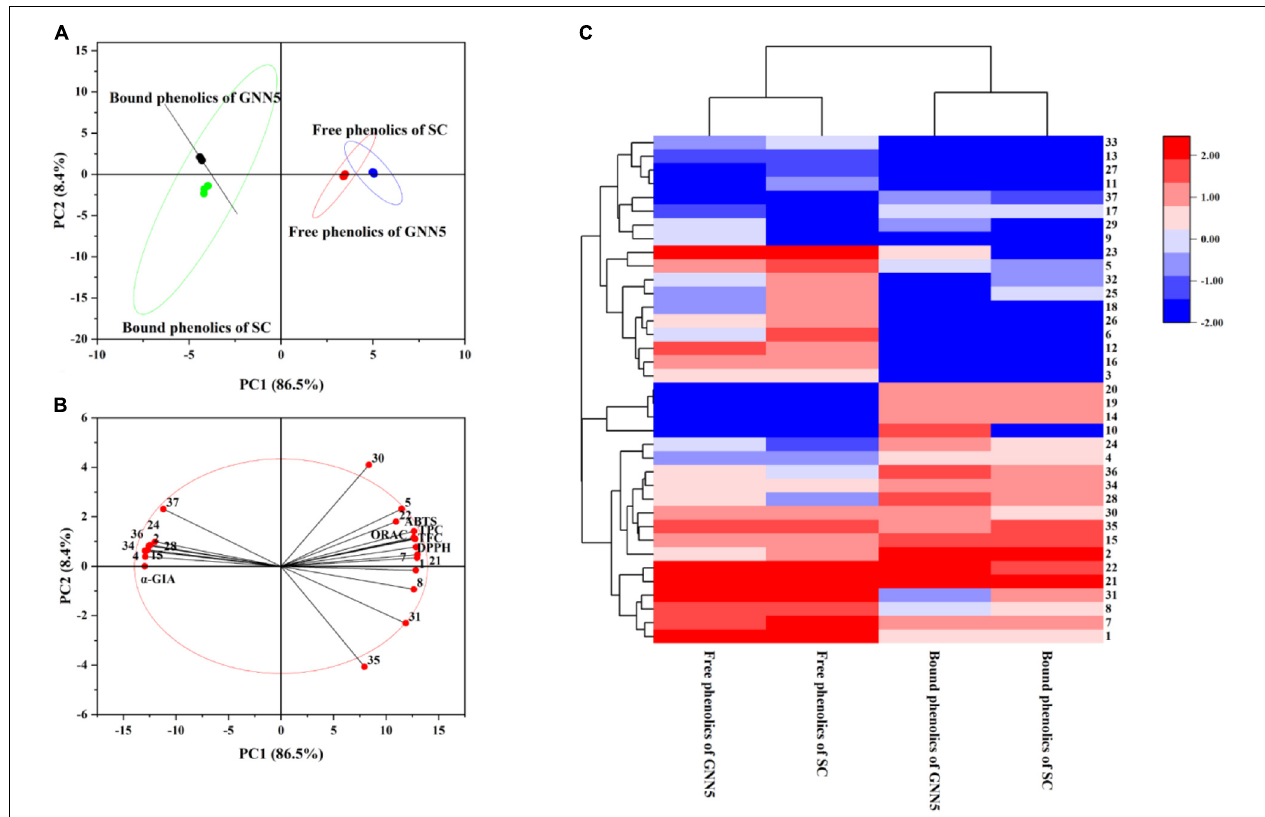
FIGURE 3 | Multivariate analysis on the datasets of two R. roxburghii leaf extracts. (A) The PCA loading plot; (B) the PCA score plot; (C) Hierarchically clustered heat (HCA) map. The component numbers are in one-to-one correspondence with Supplementary Table 1